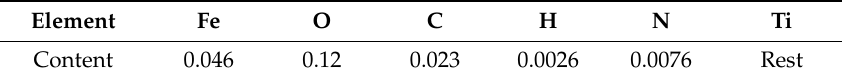
Table 1. Chemical composition of the processed material,